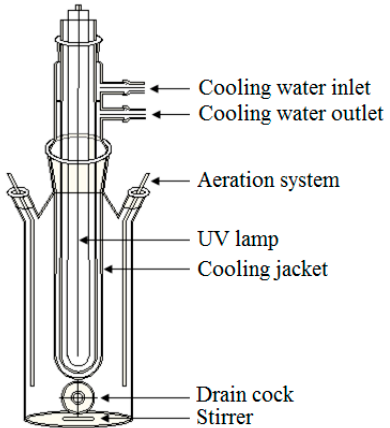
Figure 1. Scheme of the photocatalytic batch reactor.